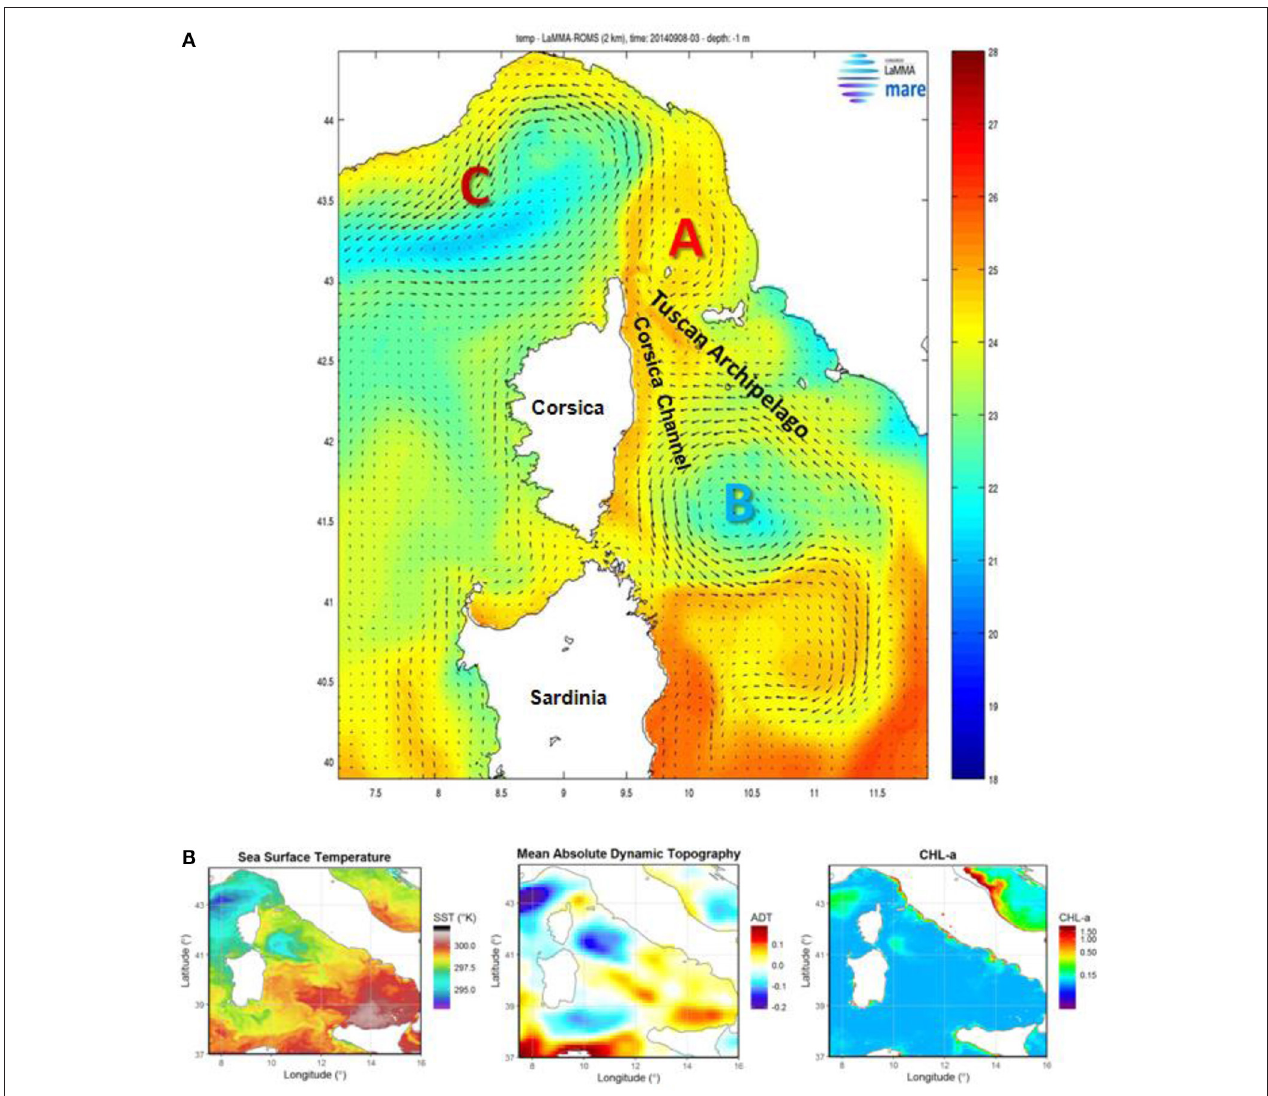
FIGURE 5 | Relevant hydrodynamic structures in the Pelagos Sanctuary area. (A) Anticyclonic circulation of the “Capraia Gyre” (Structure A), Northern Tyrrhenian Cyclone (Structure B), Ligurian current (Structure C); map produced using the Matlab Release 14 software; (B) SST, MADT, and Chla maps, 28th August 2014; maps produced using the IDL 5.6 with Rgdal R package version 1.1-3 software, and the SeaDAS 7.2 26 and R library 27 open-source